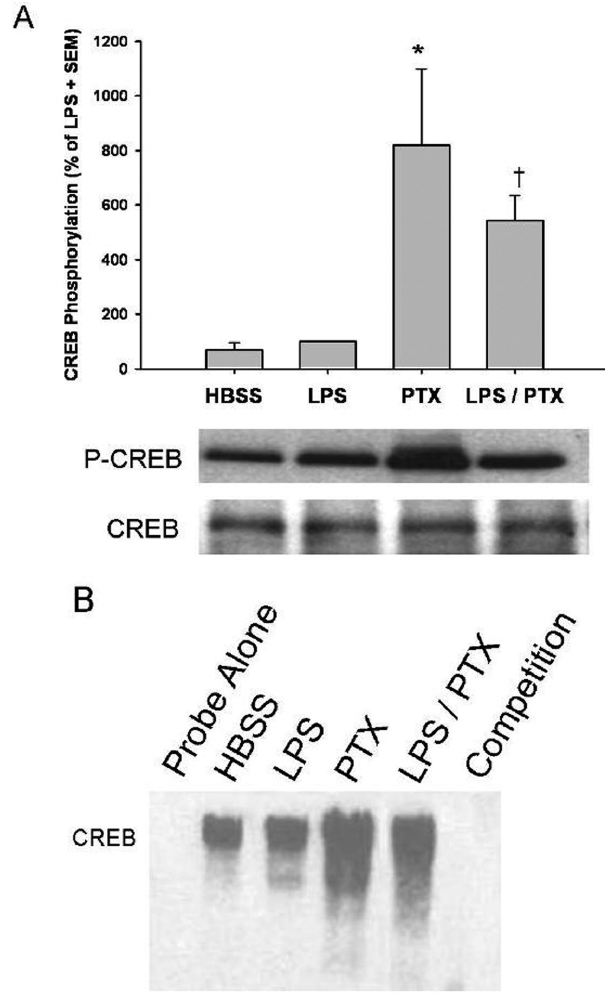
Figure 4. Effects of phosphodiesterase inhibition on LPS-induced CREB phosphorylation. Isolated human mononuclear cells (5 x 10 6 ) were incubated with LPS (1 µg/mL) in the presence and absence Pentoxifylline (PTX; 20 mM). A, CREB phosphorylation was assessed by western blotting, and the results are expressed as a percentage of LPS stimulation ± SEM ( n = 4 per group). Incubation of cells with PTX alone resulted in a concentration- dependent upregulation of CREB phosphorylation (*, P < 0.05 vs. HBSS). The concomitant administration of LPS slightly attenuated